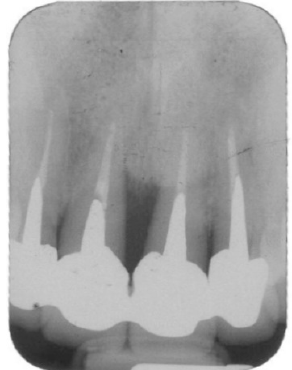
Figure 1. Periapical radiographs of a 37-year-old nonsmoker woman with hopeless 12–22 teeth due to severe bone loss (patient# 17).